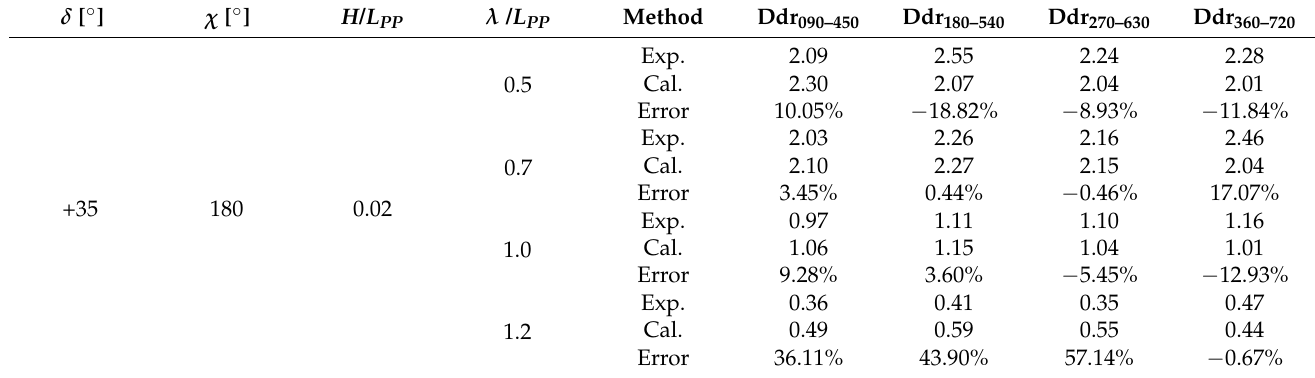
Table 6. Comparisons of trajectory drifting distances in head waves [unit: L pp (ship length)].